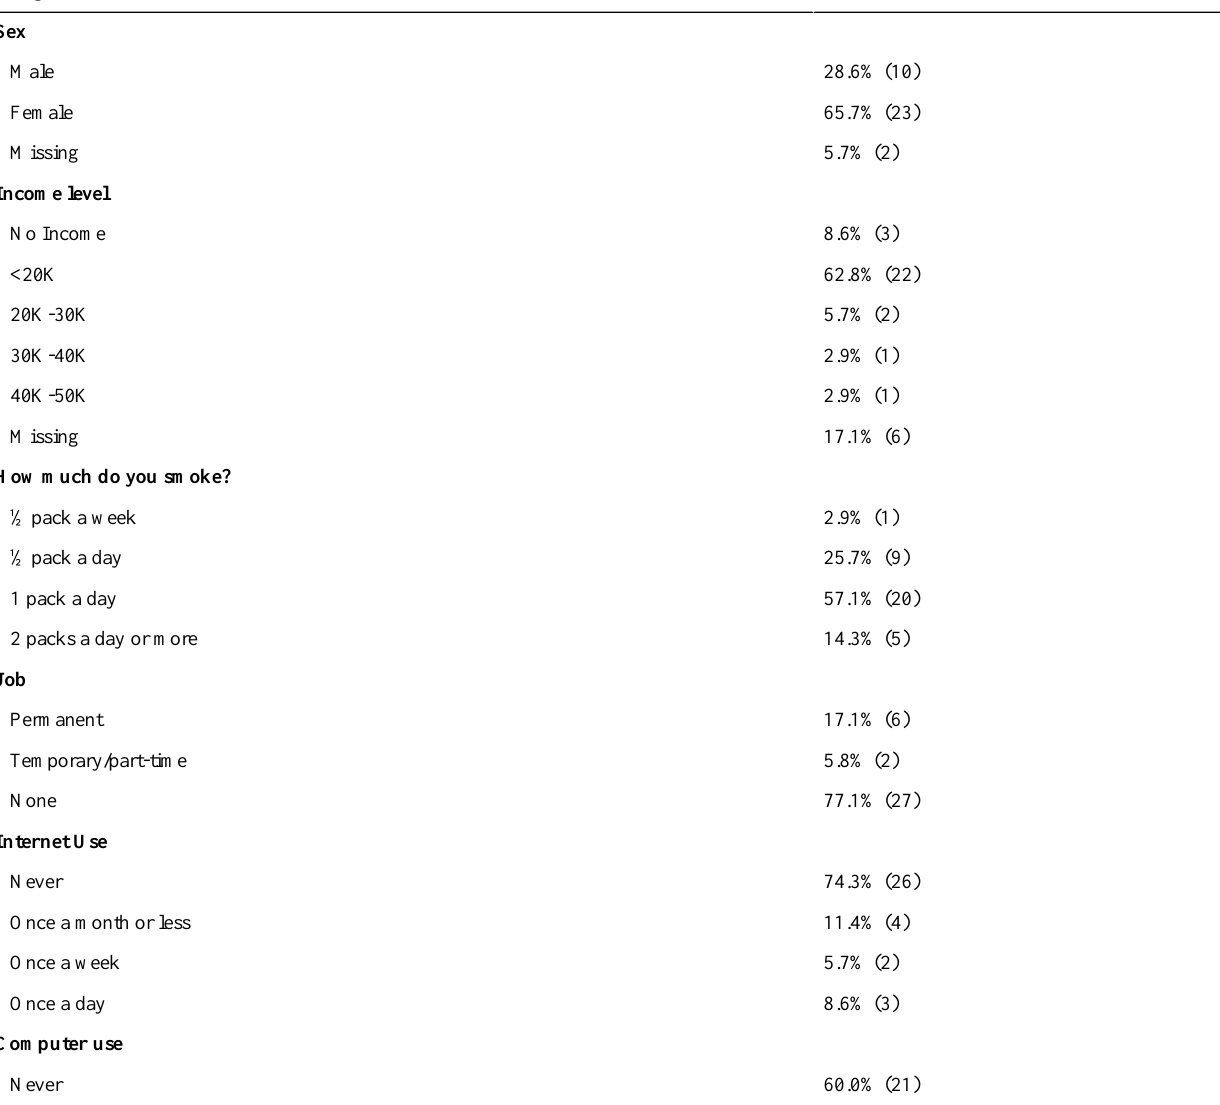
Table 2. Baseline characteristics of the study sample (N=35). See text for continuous variables (age, education, years of